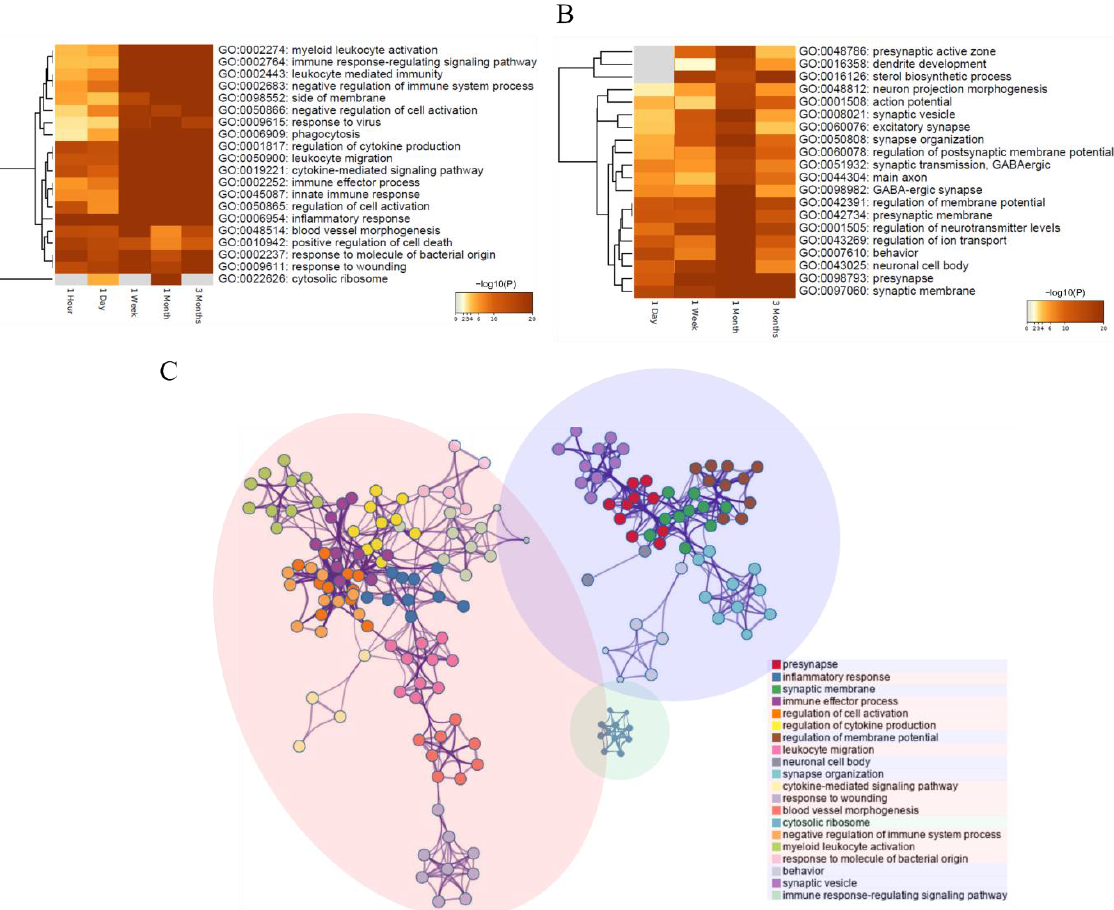
Figure 2. Functional analysis of DEGs after SCI treatment across five time periods using Metascape software. ( A , B ) The functional classification for up- ( A ) and downregulated ( B ) genes after SCI are screened and visualized. The bar chart of clustered enrichment ontology categories (GO) with a discrete color scale represents statistical significance, and white cells indicate the lack of enrichment for that term in the corresponding gene list. ( C ) A subset of representative terms from the GO cluster is converted to GO networks. The red and blue circles represent a network of GO functions involving up- and downregulated genes, respectively, and the cluster of green circles are functions that show associations on both sides. The detailed results for the functional classification and DEGs are listed in Supplemental Table S3.